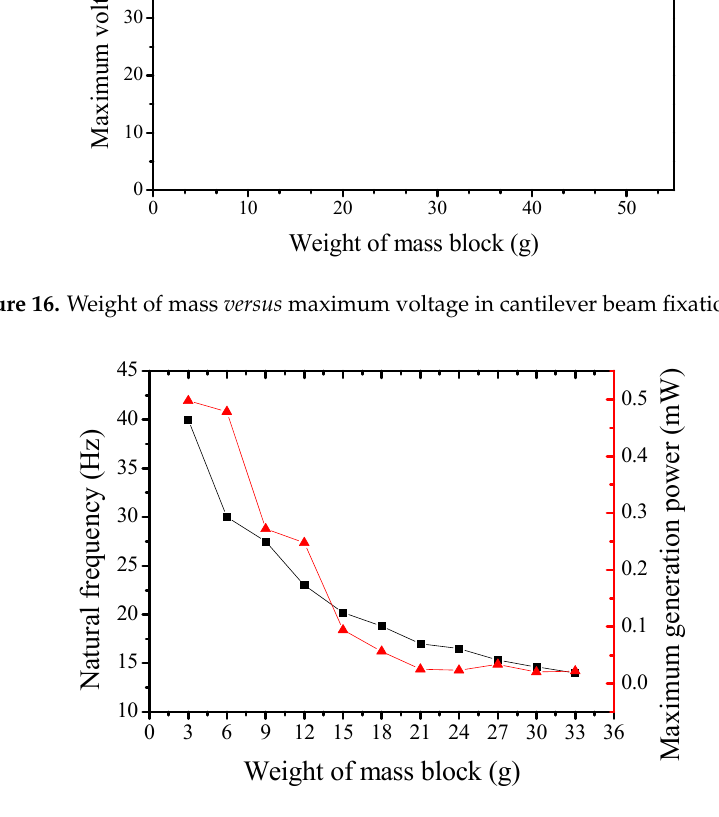
Figure 17. Weight of mass block versus natural frequency and maximum power of PCP in cantilever beam fixation mode.